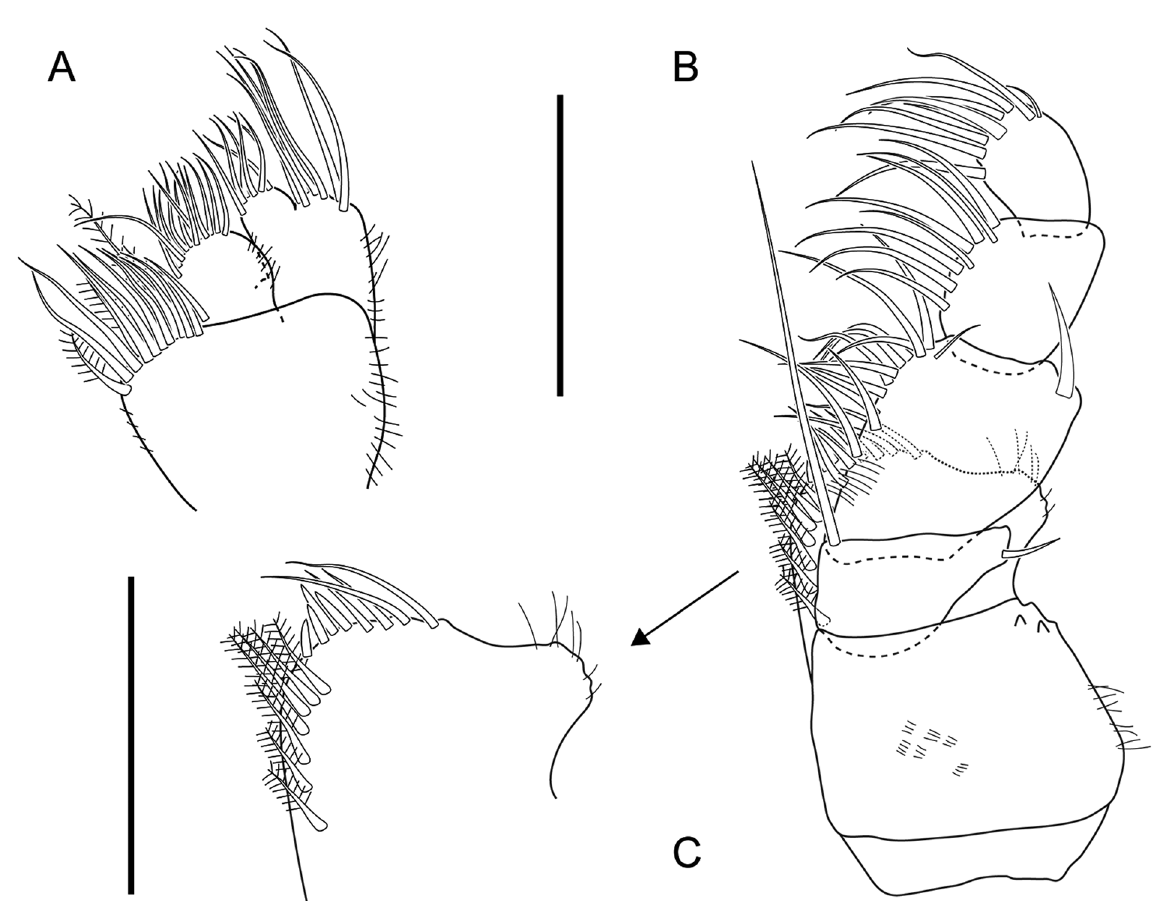
Figure 4. Apseudomorpha brasiliensis sp. nov. Paratype, ovigerous female dissected (MNRJ 29857). A Maxilla; B maxilliped; C endite of maxilliped. Scale bar: 0.1